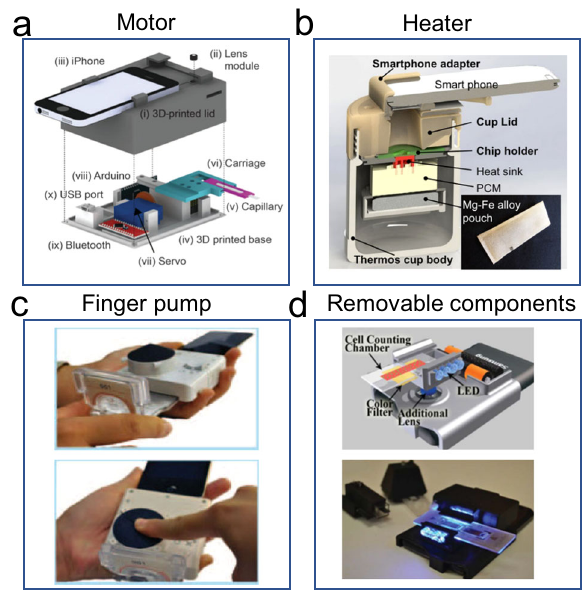
Fig. 4 | Supporting components. a Motor for FOV scanning. FOV denotes fi eld of view ( fi gure adapted with permission from D ’ Ambrosio et al. 18 ). b Heater for temperature control. PCM denotes phase-change material ( fi gure adapted with permission from Liao et al. 51 ). c Finger pump for fl ow driving ( fi gure adapted with permission from Laksanasopin et al. 17 ). d Attachment with a port for inter- changeable components interchanging ( fi gure adapted with permission from Zhu et al. 70